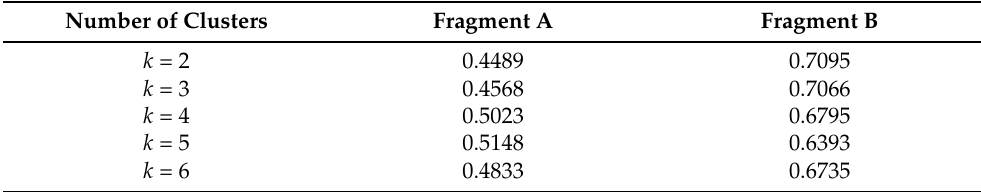
Table 2. Mean Silhouette Coefficient, ˜ s , for different number of clusters, k , for Fragment A and B. Number of Clusters Fragment